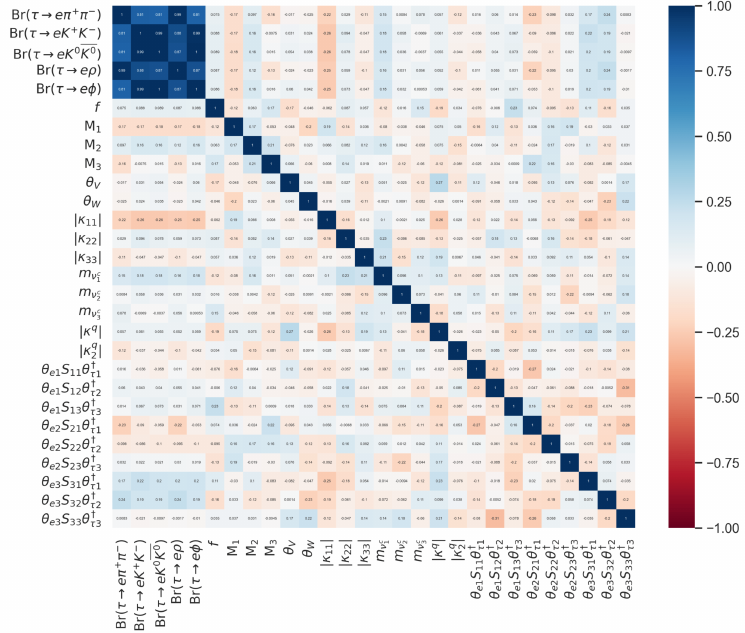
Figure 12 . Heat map for τ → ePP, eV decays and their free parameters considering Majorana